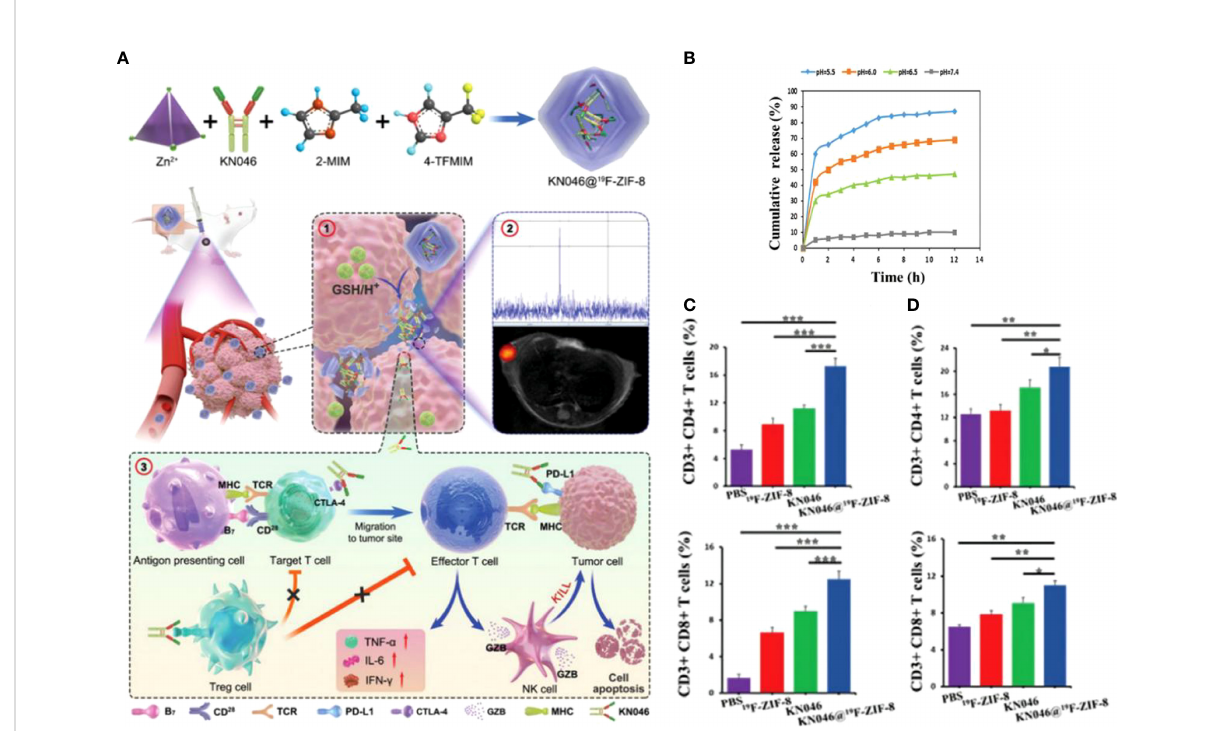
FIGURE 6 (A) . Schematic diagram of the structural composition of KN046@19 F -ZIF-8 nanoplatform and ① Schematic diagram of KN046@19 F -ZIF-8 in response to tumor microenvironment and dissolution of release. ② 19 F NMR signals response to GSH/H + . ③ KN046@19 F -ZIF-8 combined with dual-targeted immune checkpoint inhibitors for anti-tumor immunotherapy. (B) cumulative release of KN046 from KN046@19 F -ZIF-8 in PBS at different pH (pH =5.0, 6.0, 6.5, 7.4). (C, D) The number of CD4 + T and CD8 + T cells in the tumor and spleen was measured and quanti fi ed by fl ow cytometry after treatment with different treatment regimens (PBS, 19 F -ZIF-8, KN046, KN046@19 F -ZIF-8) for the tumor-bearing mice. Data are expressed as mean ± SD (n = 5, *p < 0.05, **p < 0.01,***p < 0.001) (128). Reprinted with permission from Ref.